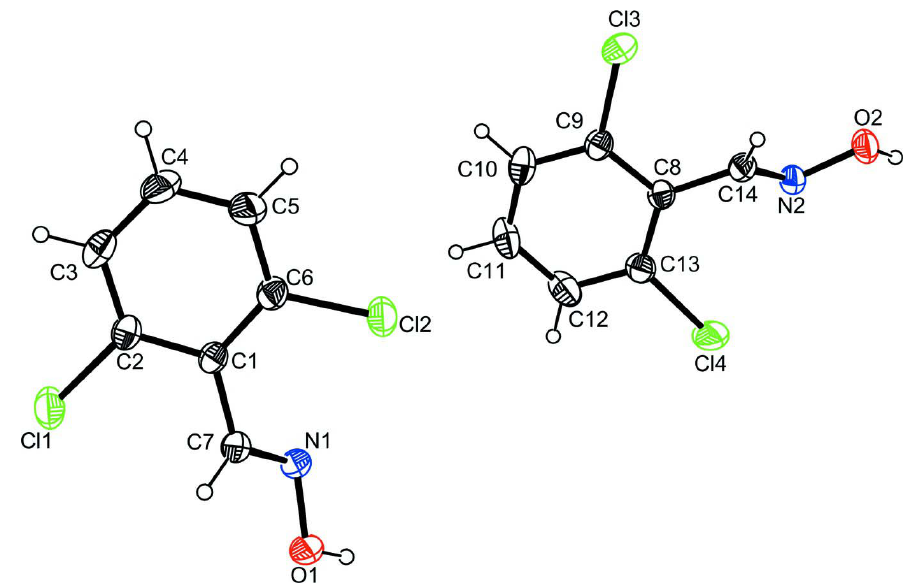
Figure 1 The asymmetric unit of (I) with the atom-labelling scheme. Displacement ellipsoids are drawn at the 30% probability level. H atoms are represented as small spheres of arbitrary